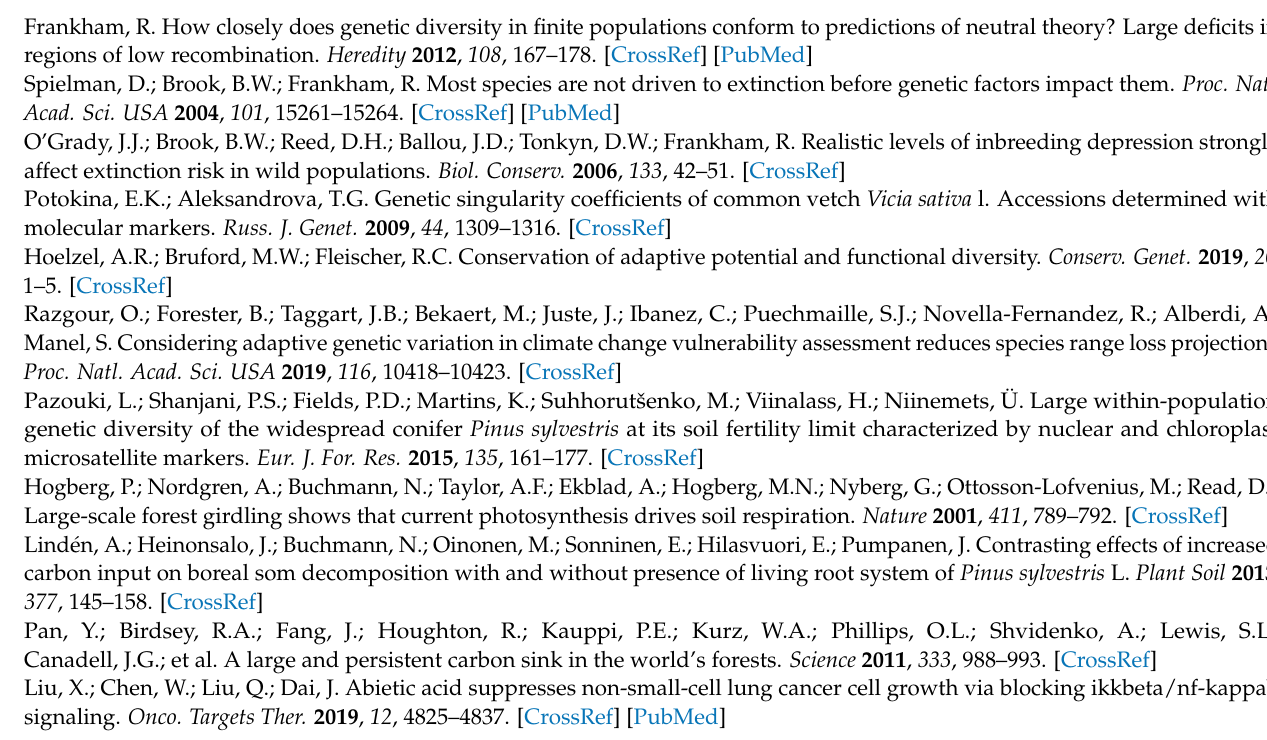
(DN) between the populations studied Pinus sylvestris L. Supplementary Table S5. Regression analysis of genetic and geographical distances. Supplementary Figure S1. Schematic map of the location of the studied populations of P. sylvestris . Supplementary Figure S2. Allele patterns of P. sylvestris populations. Supplementary Figure S3. Ordination of the studied populations of P. sylvestris using PCA, obtained on the basis of PhiPT matrix of genetic distances. Supplementary Figure S4. The structure of the distribution of genotypes in P. sylvestris populations. Supplementary Figure S5. Graph of dependence of genetic (DN) and geographical distances of P. sylvestris